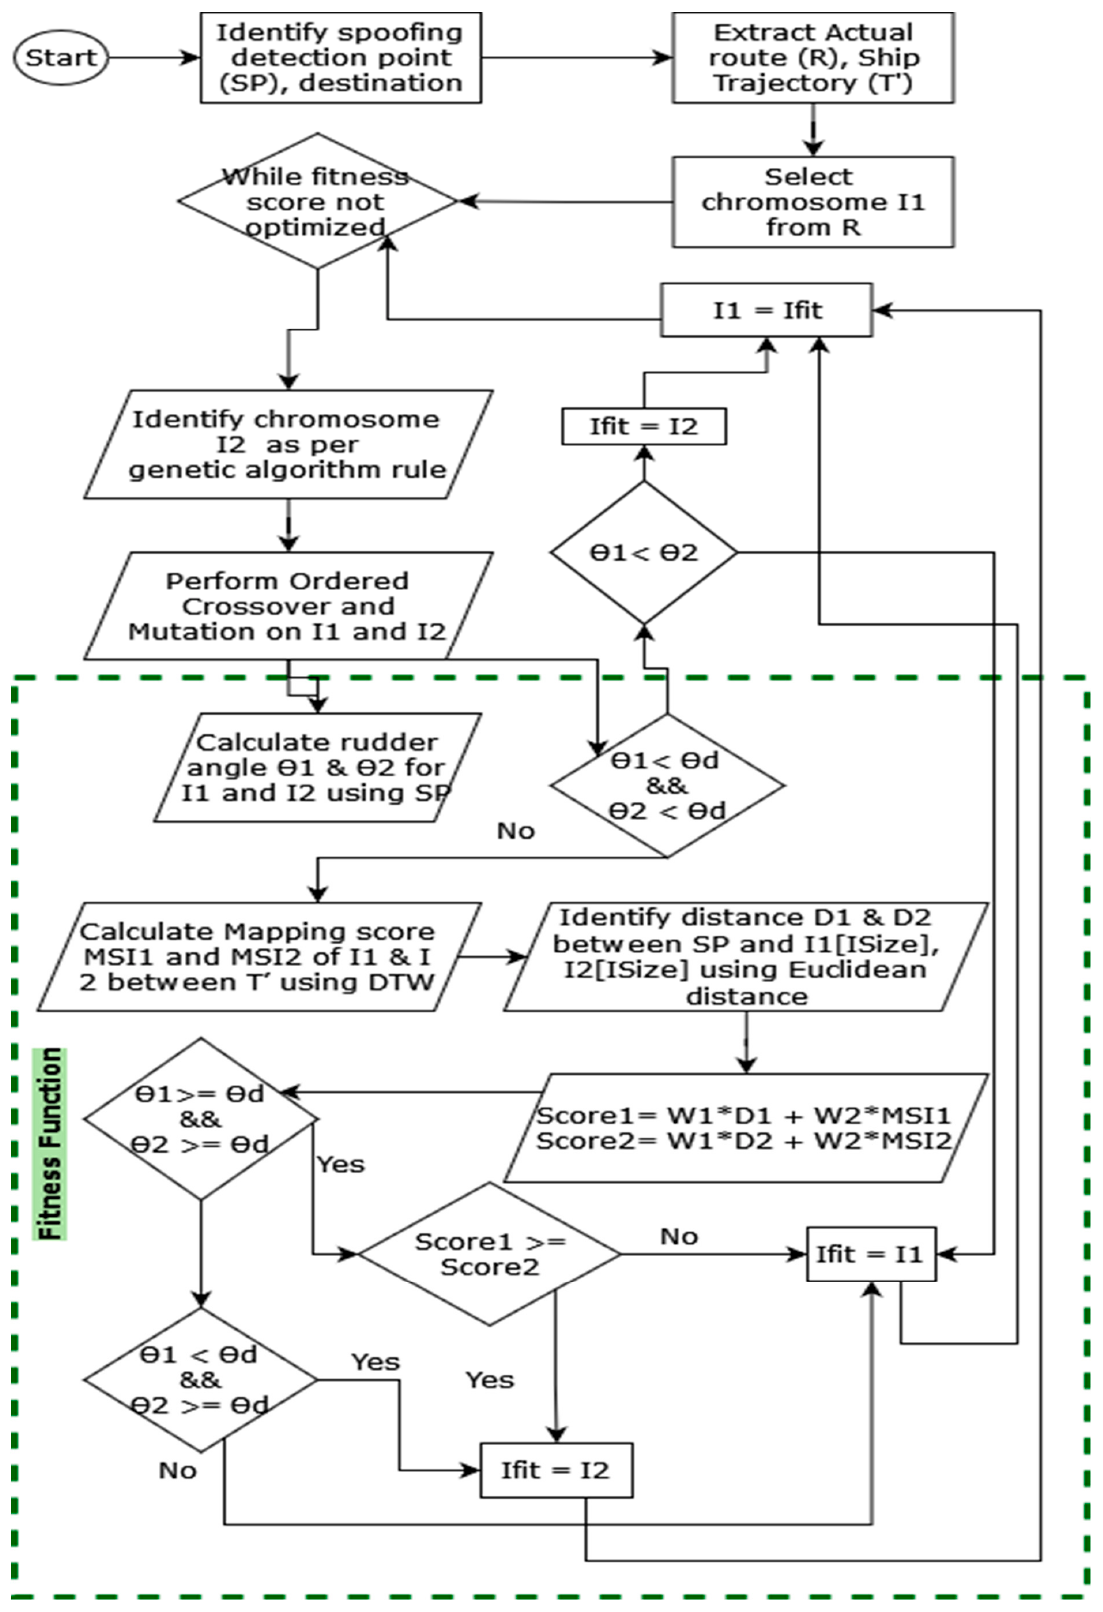
Figure 5. Flow chart of GNSS Spoofing detection technique using the genetic algorithm.